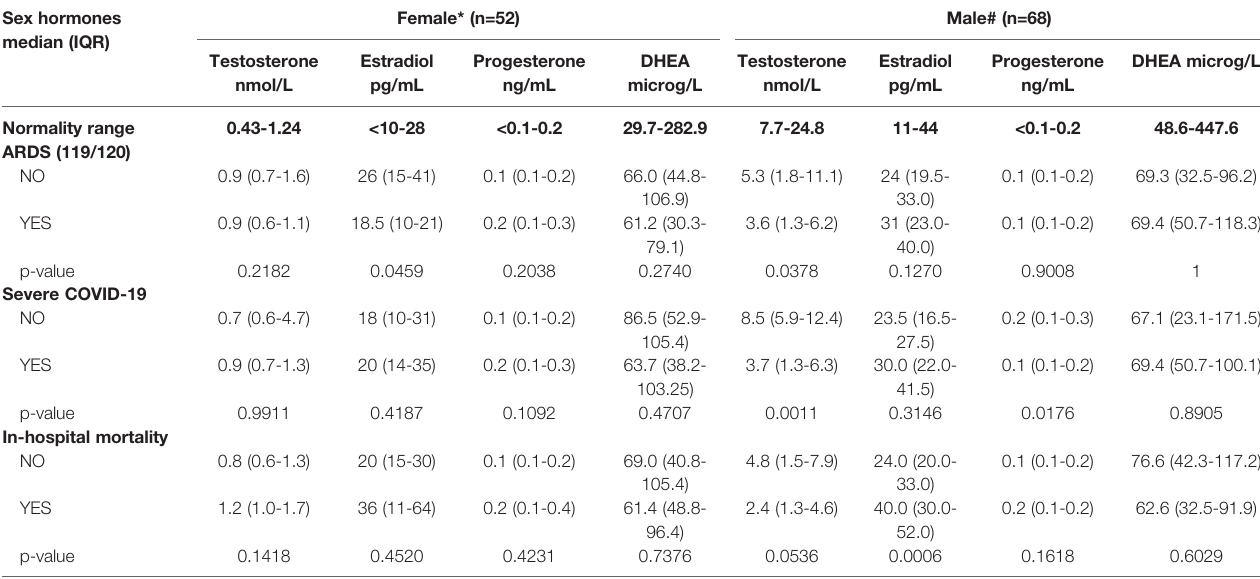
TABLE 4 | Sex hormone levels in patients aged 50 years and over, strati fi ed by sex and outcome. Sex hormones median